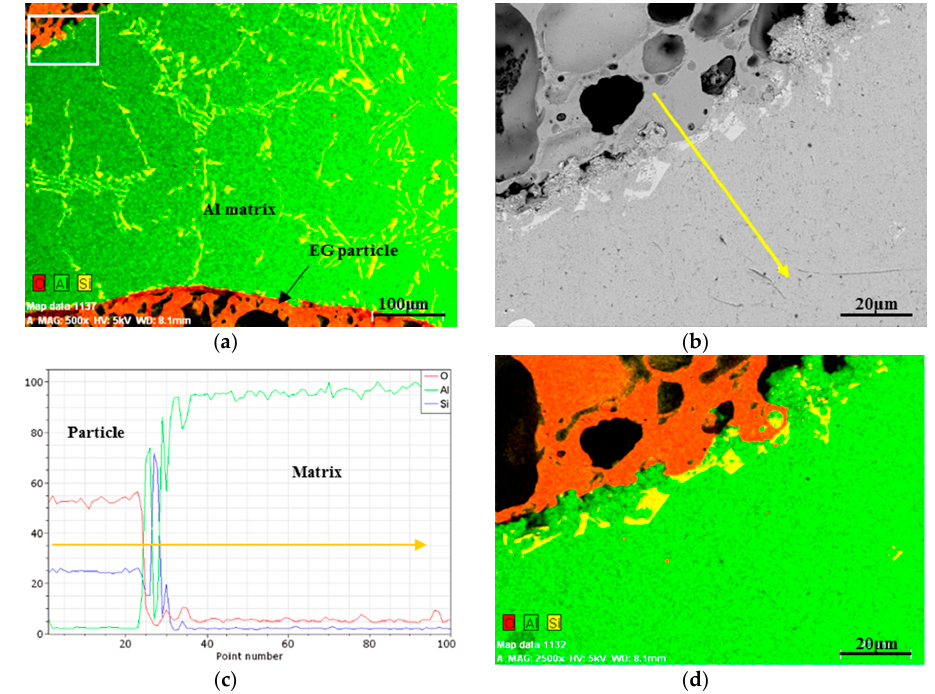
Figure 6. ( a ) BSE image of base metal; ( b ) BSE image of the interface; ( c ) EDS line-scan profiles of the EG-A356 syntactic foam; and ( d ) elemental analysis image X-ray map of the interface area.